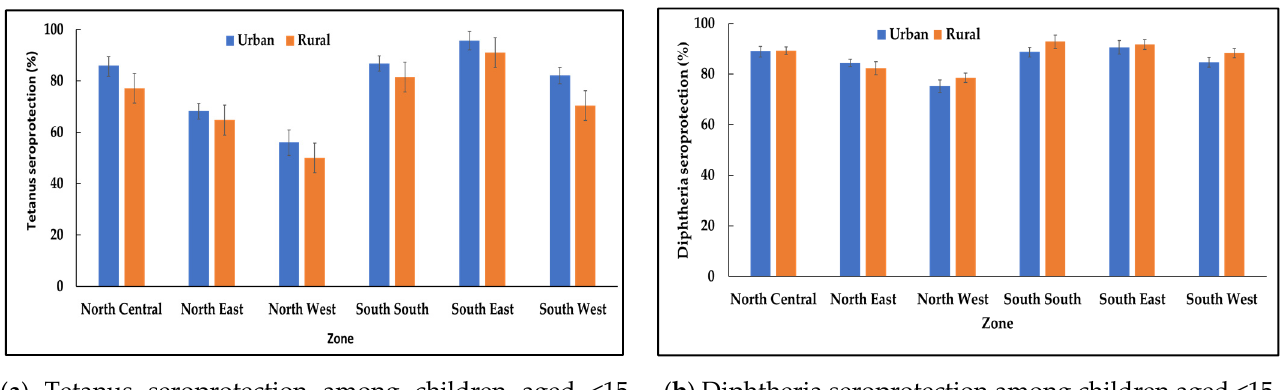
Figure 2. Tetanus and diphtheria minimal seroprotection ( ≥ 0.01 IU/mL) among children aged <15 years by zone and location, Nigeria, 2018 ( a , b ).